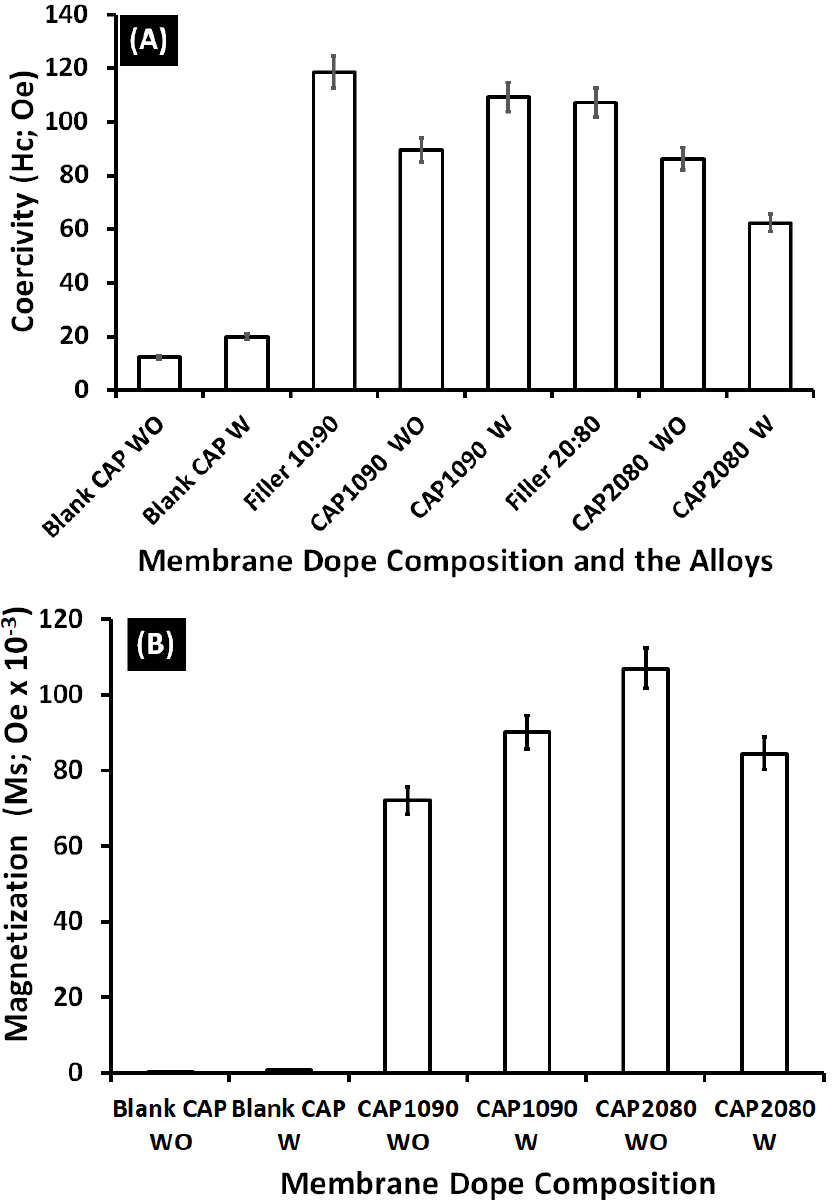
Figure 13. ( A ) Coercivity (Hc; Oe) and ( B ) magnetization (Ms) of the iron–nickel alloys/fillers (Fe 10 Ni 90 and Fe 20 Ni 80 ) as well as the blank cellulose acetate (CA) and the magnetic mixed CA matrix membranes without and with the addition of 0.1 wt.% of lithium chloride in the membrane dope. Poly(methylmethacrylate) (0.8 wt.%) was used in the membrane dope of all the prepared membranes.